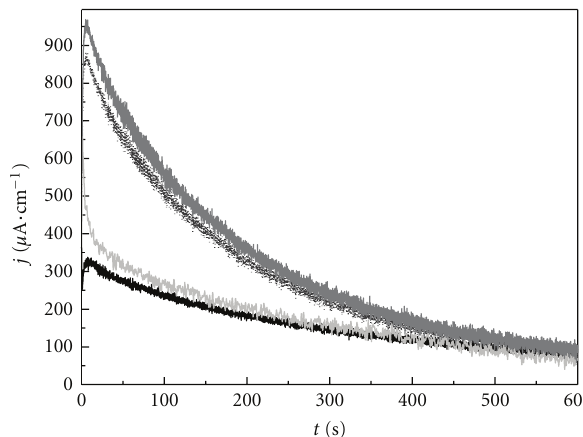
Figure 4: Chronoamperometric plots for methanol oxidation in oxygen-free 0.1 M methanol + 1 M sulphuric media at 700mV on: pc Pt (black lines), Pt F100 (light grey lines), CT Pt (grey lines), and Pt F111 (dark grey